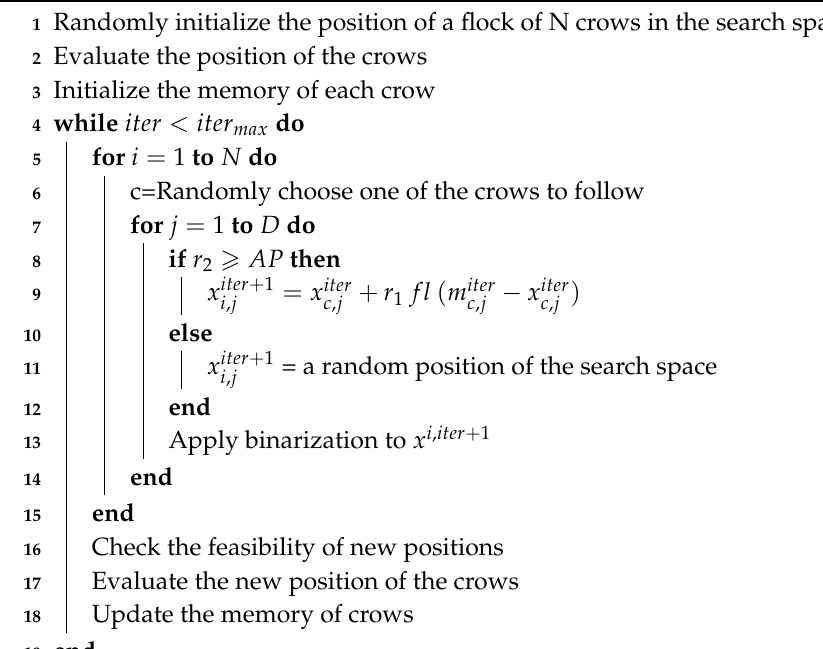
Algorithm 4: CSA + Two-steps and Kmeans binarization techniques pseudo-code